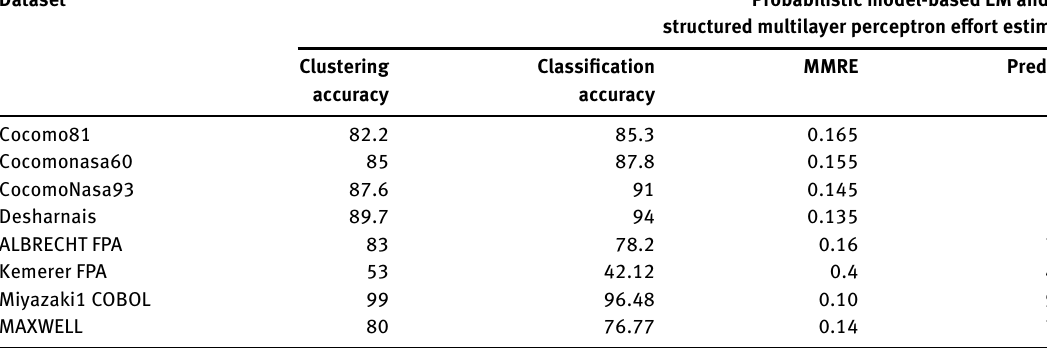
Table 4: Deep Structured Multilayer Perceptron Effort Estimation Using Probabilistic Model-Based Expectation-Maximization (EM) Clusters.